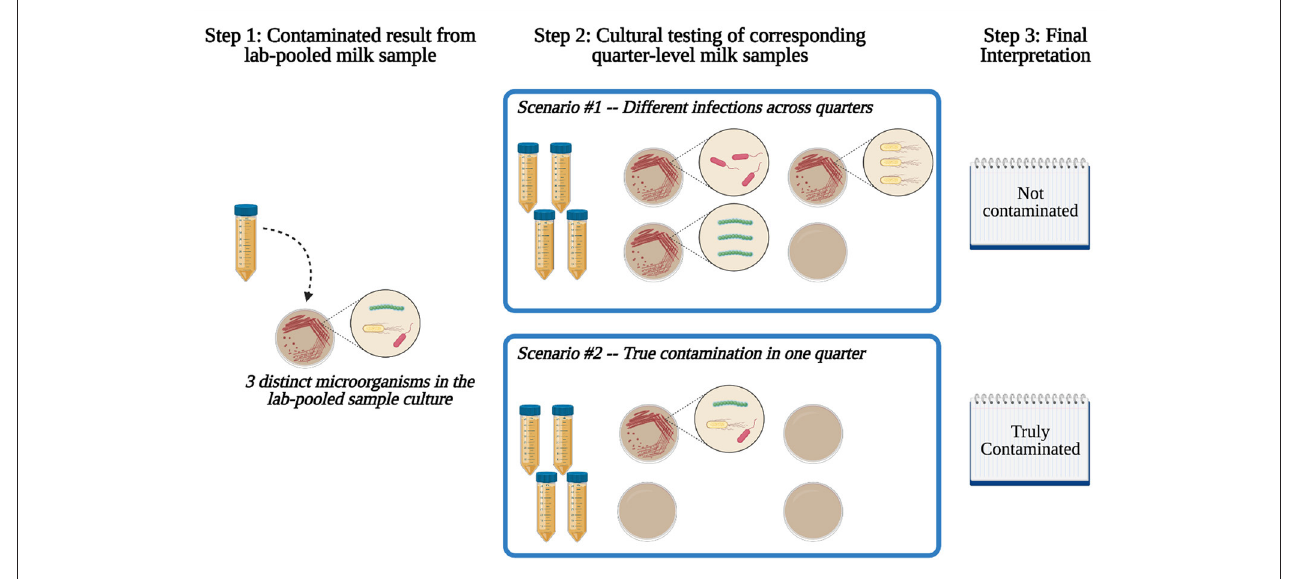
FIGURE 1 | Possible scenarios and interpretations for a lab-pooled milk sample. In scenario #1, distinct pathogens are present across different quarter milk samples, resulting in a lab-pooled milk sample that should be classified as “not contaminated”. In scenario #2, three pathogens are present in a single quarter milk sample, resulting in a lab-pooled milk sample that should be classified as “truly contaminated”.